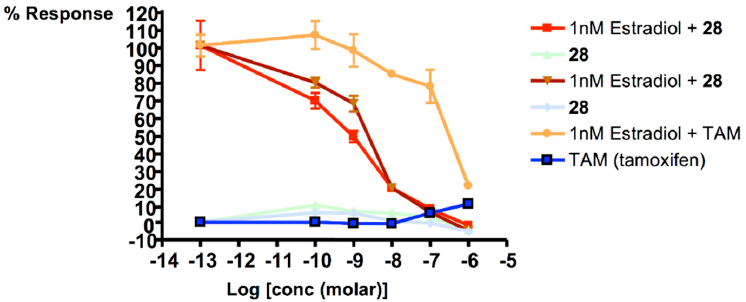
Figure 2. Effect on alkaline phosphatase activity of conjugate 28 and tamoxifen in Ishikawa cells.